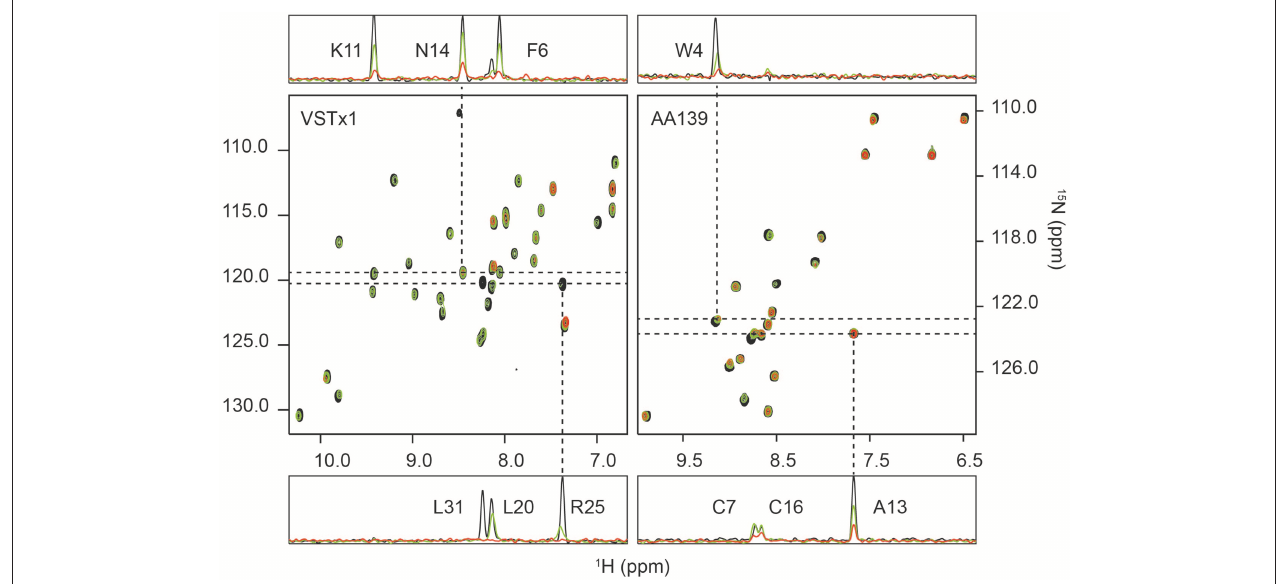
FIGURE 3 | 1 H- 15 N HSQC titrations of membrane-active peptides against nanodiscs containing bacterial model membranes. (Left) The titration of ion-channel inhibitor VSTx1 (20 µ M) against increasing concentration of nanodiscs [POPC:POPG (4:1)]. The three superimposed spectra correspond to a [peptide]:[nanodisc] ratio of 1:0 (black), 1:0.25 (green) and 1:1 ( red). (Right) The titration of antimicrobial peptide AA139 (40 µ M) against increasing concentration of nanodiscs [POPC:POPG (4:1)]. The three superimposed spectra correspond to a [peptide]:[nanodisc] ratio of 1:0 (black), 1:0.25 (green) and 1:0.375 (red). In both cases 1D traces are shown at 15 N frequencies corresponding to peaks that show a small change in intensity that does not fit to the binding isotherm (N14 for VSTx1 and Ala13 for AA139), and a signal (Arg25 for VSTx1 and Trp4 for AA139) having a strong intensity change that fits the binding isotherm. The latter also display an observable chemical shift and linewidth change consistent with intermediate exchange due to binding. Assignments are provided in 1D